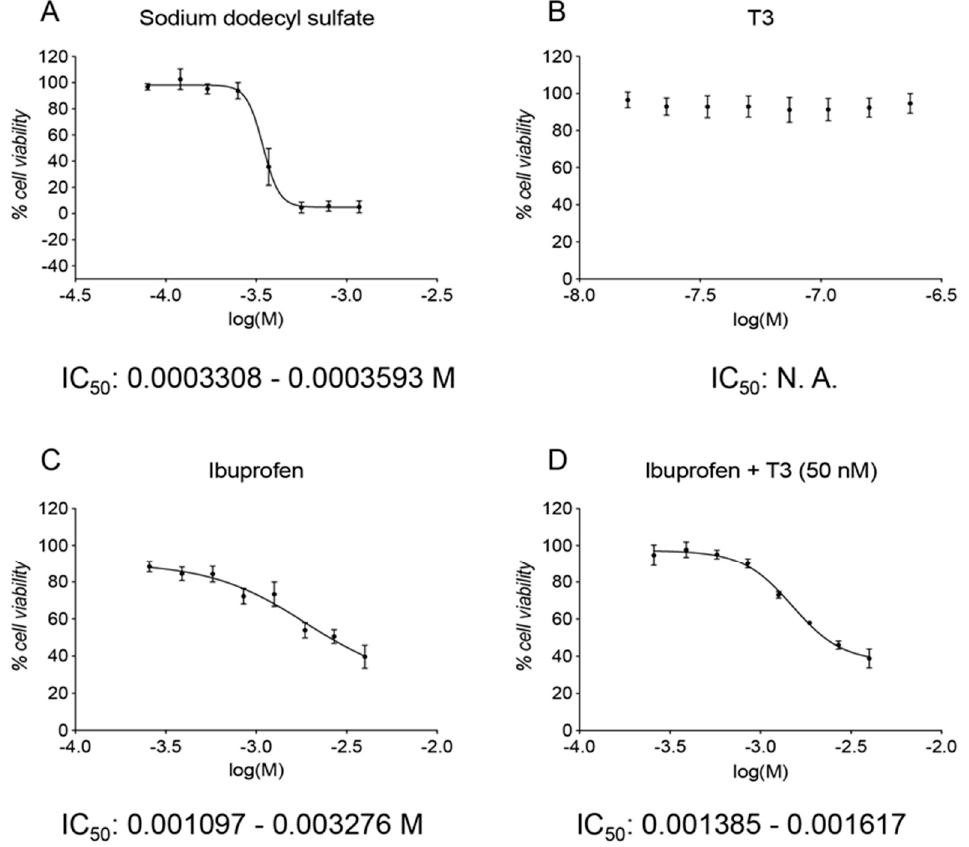
Figure 2. GLP toxicity study of the Ibu–T3 combination. The graphs show the cell viability normalized on the vehicle control group (100%) of cells exposed to different doses of sodium dodecyl sulfate ( A ), triiodothyronine ( B ), ibuprofen ( C ), and ibuprofen in the presence of a fixed dose of triiodothyronine ( D ). Concentrations on the x-axis are shown as the log of the Molarity; log(M). For each graph, the IC 50 value is shown as Molarity ( A , C , D ) or as N. A. (not-applicable; ( B )) if it was not possible to calculate the value.